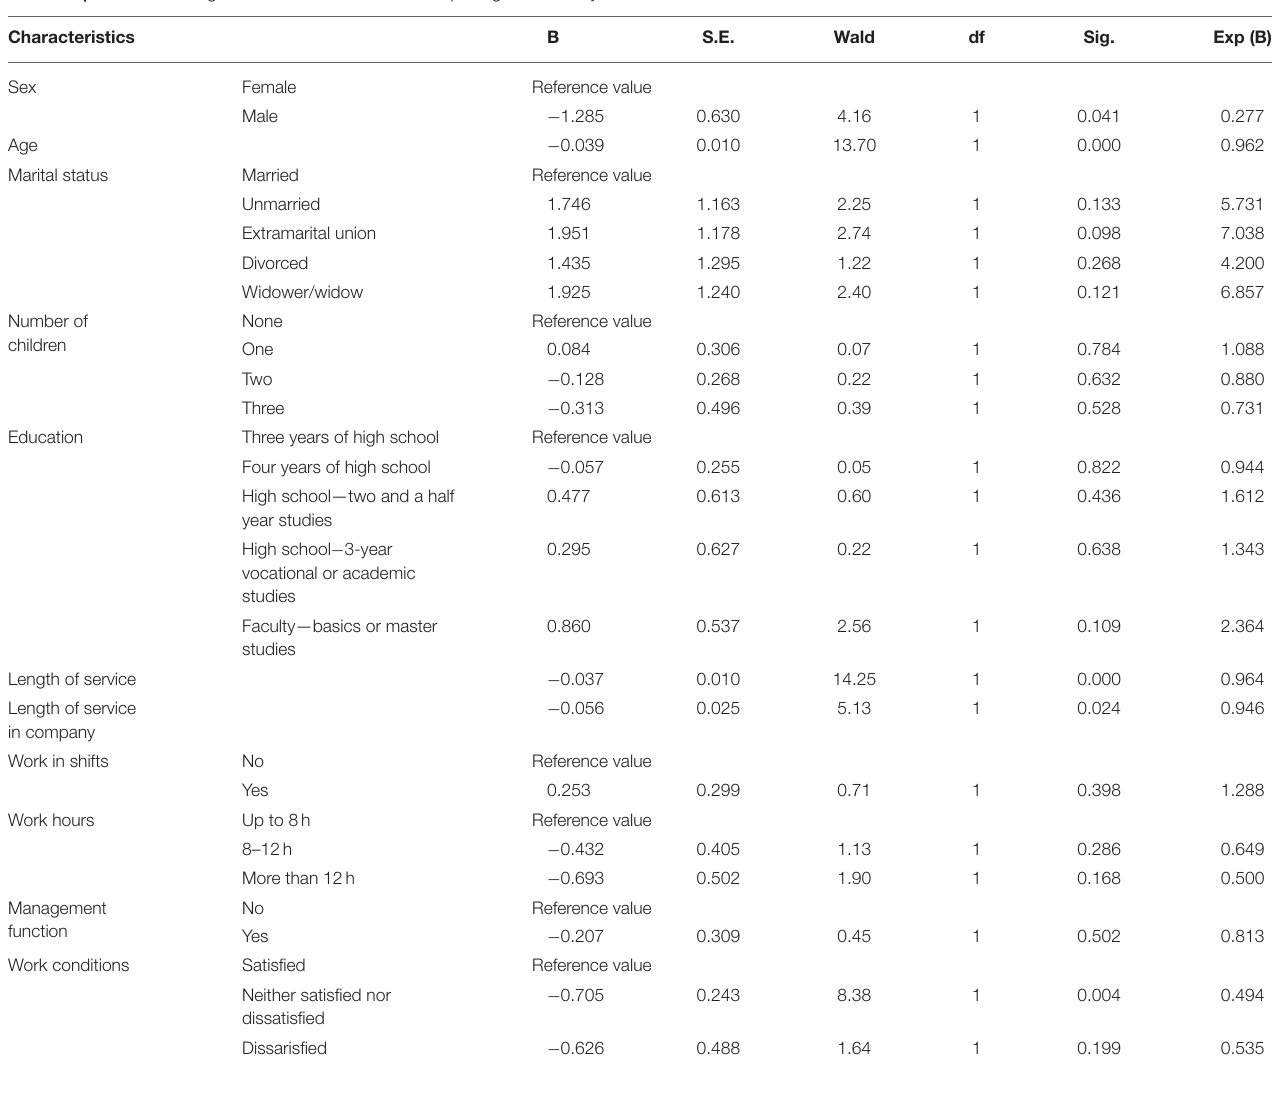
TABLE 4 | Factors affecting the EE variable: results of multiple regression analysis.